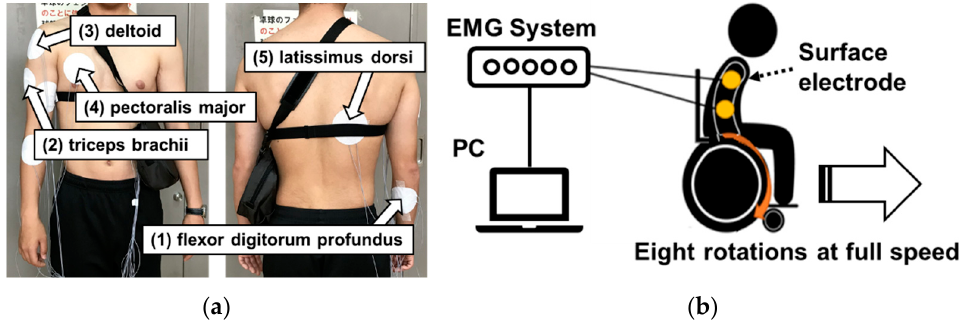
Figure 2. Measurement position of sEMG and schematic diagram I: ( a ) five measurement points and ( b ) schematic diagram of the experiment.